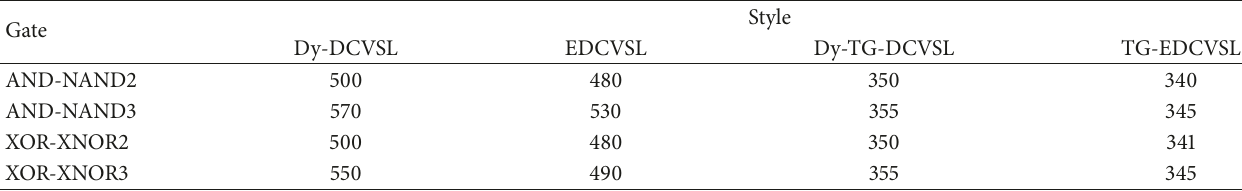
Table 1: Summary of delay results (ps).